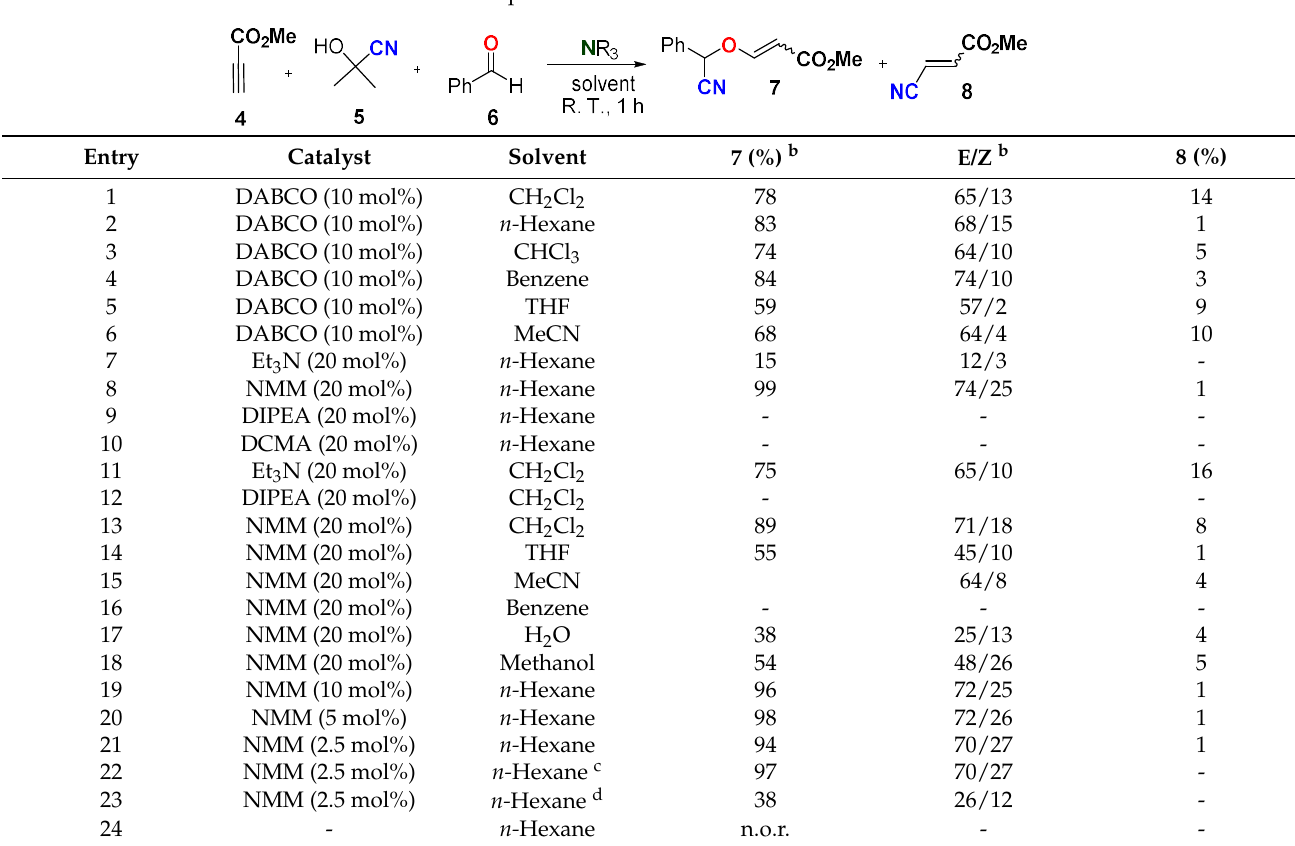
Table 1. Optimization of the 3CR manifold a .